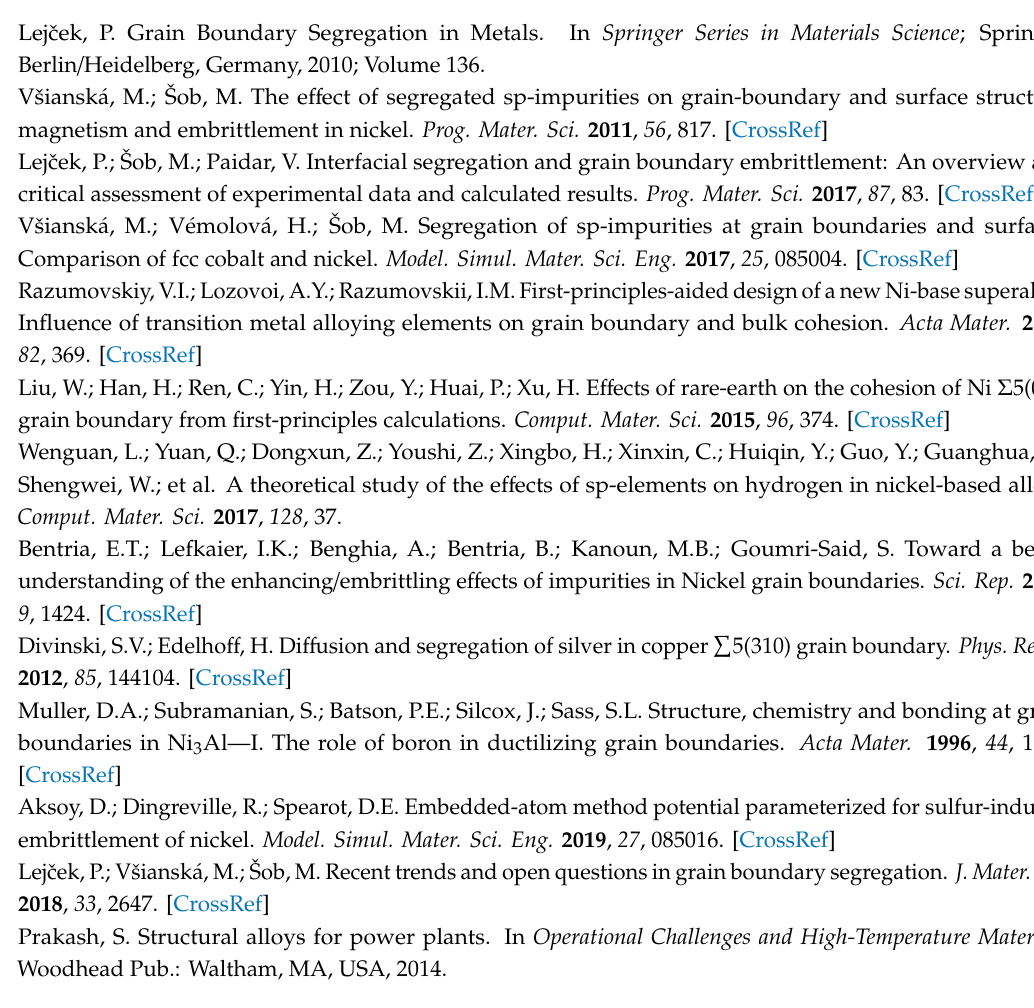
Table S1: Data depicted in Figure 4: the equilibrium interlayer distances D for structures GB-Ni 60 , GB-Ni 118 Al 2(s) , GB-Ni 118 Si 2(s) and GB-Ni 120 Si 2(i) obtained from the automatic relaxation. Here, the interlayer distance of type 2 / 3 stands for the distance between the 2nd and 3rd layer under the assumption that the 1st layer is the layer of GB. Further, Ni,Ni and X,Ni stand for the clean plane and the plane with impurity X = Al, Si,